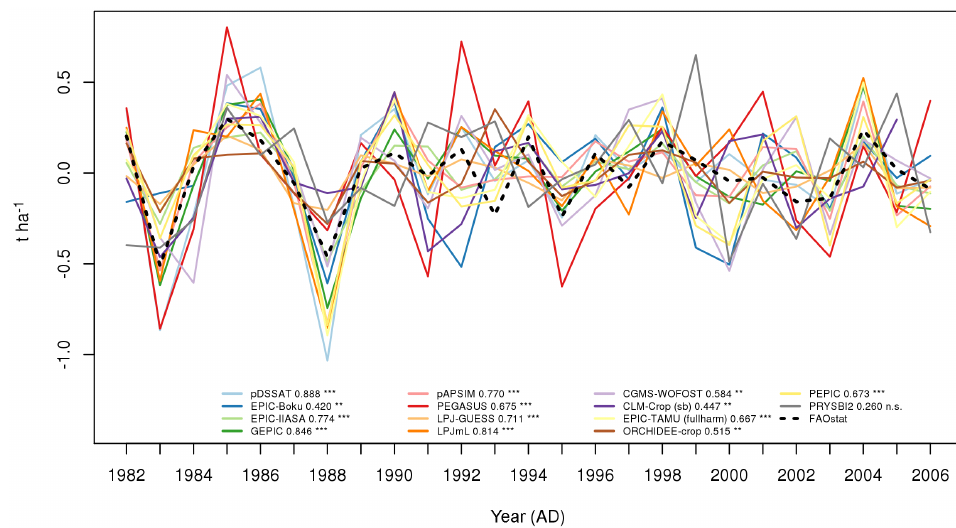
Figure 1. Time series of GGCMI simulations (solid colored lines) and FAOstat reference data (dashed line) for maize after de-trending. Numbers in the legend next to model names indicate the Pearson correlation coefficient, asterisks indicate the p values (*** for p < 0.001, ** for p < 0.05, * for p < 0.1, n.s. for not significant). This figure displays the “default” setting, except for EPIC-TAMU, which only supplied the fullharm setting simulations (see Table 2). The (sb) flag indicates that the time series had been shifted backwards by a year to achieve a better match.